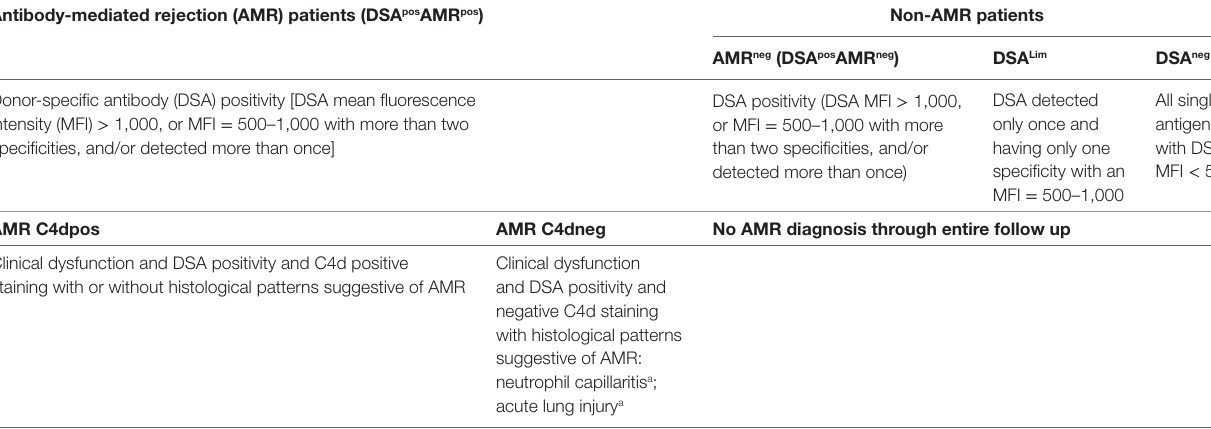
Table 1 | Criteria for antibody-mediated rejection-donor-specific antibody status